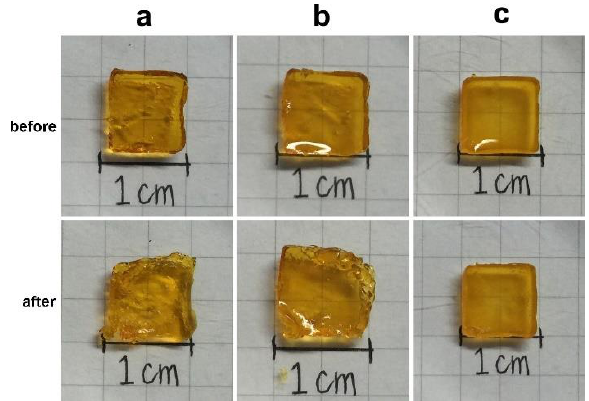
Figure 9. Images of sample used in the compressive test. The gel samples, ( a ) gelatin, ( b ) gelatin containing 20% mesoporous bioactive glass (MBG), and ( c ) 90G10C containing 20% MBG, were irradiated by an LED curing light for 120 s (before) and then were placed on the stage of the material testing system machine (MTS) under compressive test (after).